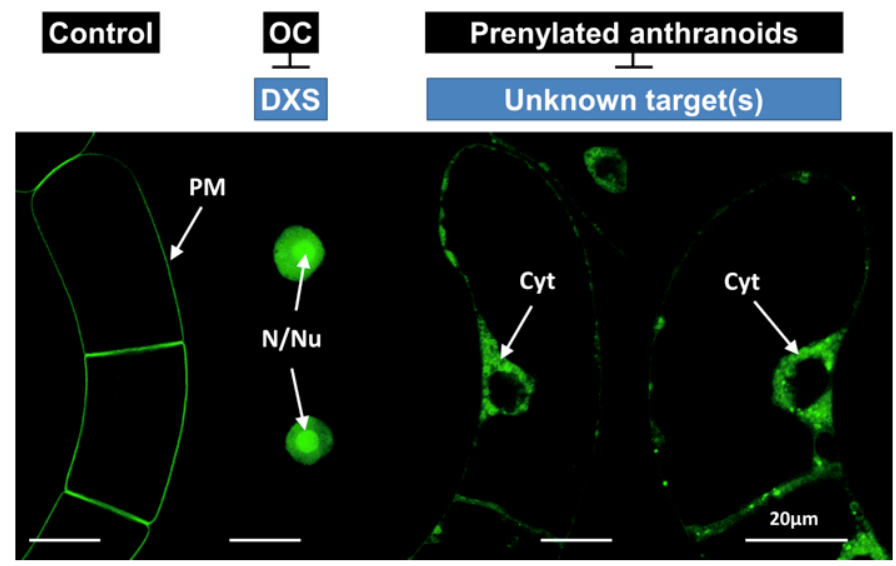
Figure 18. Confocal images indicating the unusual distribution of HH -GFP-BD-CVIL in response to a prenylated anthracenoid derived 6 from an African medicinal plant. On the left side as controls cells without and with oxoclomazone (OC) treatment showing plasma membrane (PM) localization or its mislocalization to the nucleus (N), especially in nucleoli (Nu). On the right side cells are depicted that have been treated with an inhibitor that has shown a high efficiency in killing protozoan Leishmania cells, responsible of leishmaniasis. The �� -GFP-BD-CVIL is 6 mainly accumulated in the cytoplasm (Cyt) that is for instance surrounding the nucleus. At the higher magnification some punctuate structures become visible. That might result from coagulated cytoplasm typical of cell death. White bars in the combined images represent 20